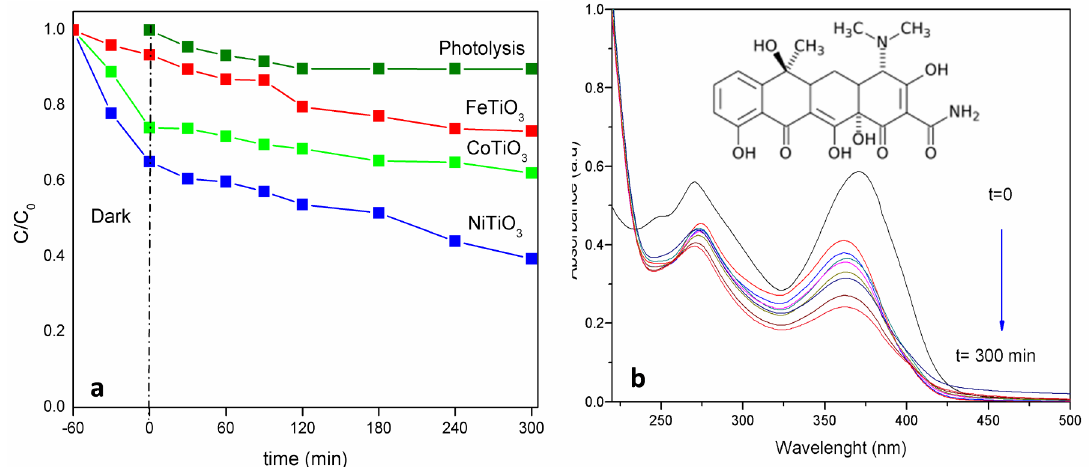
Figure 9. Photocatalytic degradation of an aqueous solution of Tetracycline with the phases synthesized by solvo-combustion method, the samples were analyzed by UV-vis spectroscopy and relative concentration of the drug as a function of time during the Photocatalytic degradation with NiTiO 3